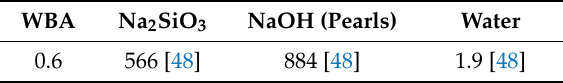
Table 3. Raw materials cost ( € · t − 1 ).